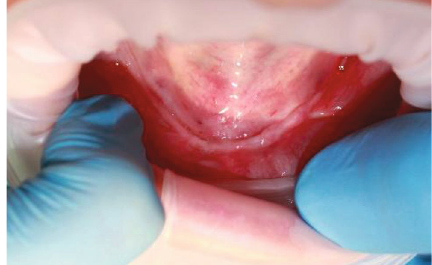
Figure 1: Oral cavity examination. Severe atrophy of the alveolar mandible.